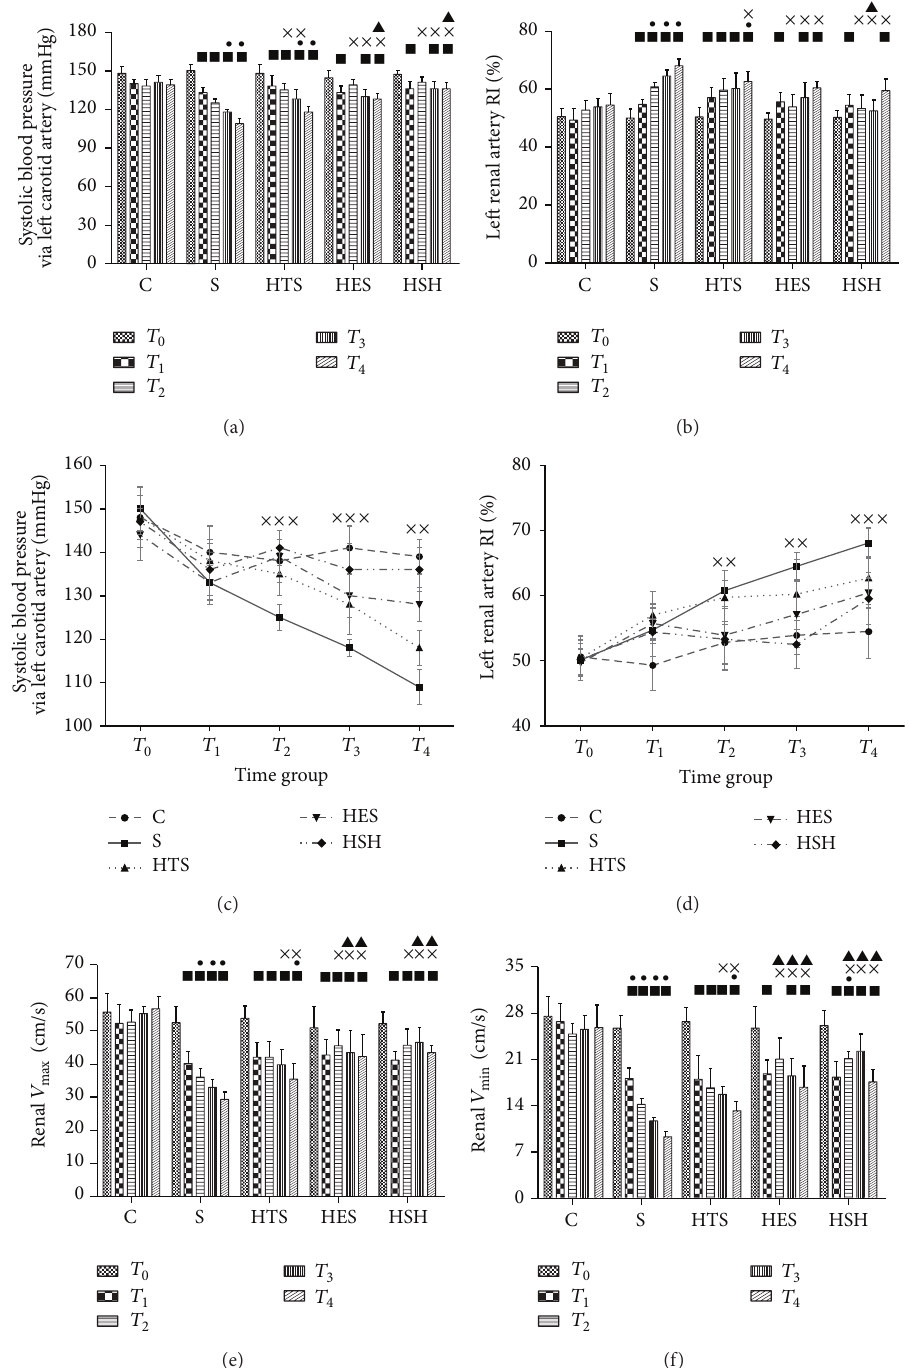
Figure 3: Small-volume resuscitation improved systemic and renal hemodynamics (mean ± SEM, 𝑛 = 6 ). (a), (b), (e), and (f) show the early stage alterations to SAP, RVRI, 𝑉 max , and 𝑉 min in different groups over time. ◼ 𝑃 ≤ 0.05 versus 𝑇 0 ; e 𝑃 ≤ 0.05 versus 𝑇 1 ; × 𝑃 ≤ 0.05 versus group S; 󳵳 𝑃 ≤ 0.05 versus group HTS. (c) and (d) are the line charts for mean arterial blood pressure (MAP) expressed in mmHg throughout the experimental procedure and left renal artery RI (RARI) expressed as (𝑉 max − 𝑉 min )/𝑉 max . ××× 𝑃 ≤ 0.05 , S versus HTS, HES, and HSH; ×× 𝑃 ≤ 0.05 , S versus HES and